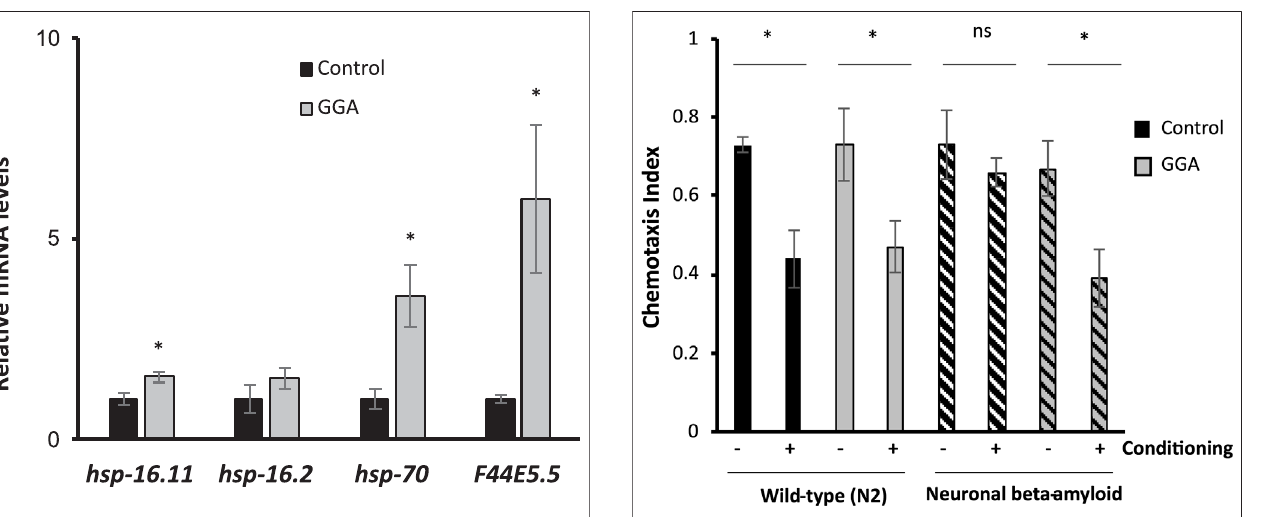
FIGURE 3 | GGA restores associative learning in a neuronal Alzheimer ’ s disease model. Transgenic worms with or without neuronal beta-amyloid expression were synchronized and incubated on NGM control or 10 μ M GGA platesat16 ° C.On dayone ofadulthood, worms wereshiftedto25 ° Cfor 24 h to induce beta-amyloid expression. Then, worms were starved in the presence or absence of the odorant diacetyl for 2 h and scored for chemotaxis. Worms expressing neuronal beta-amyloid exhibited a defect in conditioned learning that was restored upon exposure to GGA. Averages shown are from 3 biological replicates of n ≥ 30 adults each. Error bars represent SEM; * indicates p-value < 0.05; ns = non-signi fi cant (Student ’ s